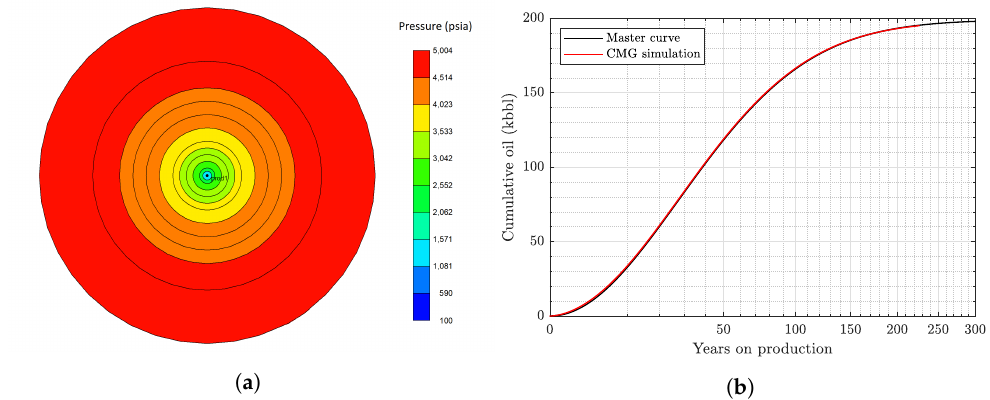
Figure A9. ( a ) A cylindrical reservoir model using the commercial reservoir simulator, CMG; ( b ) Com- parison between the physical scaling curve (black) and simulation result from CMG (red).